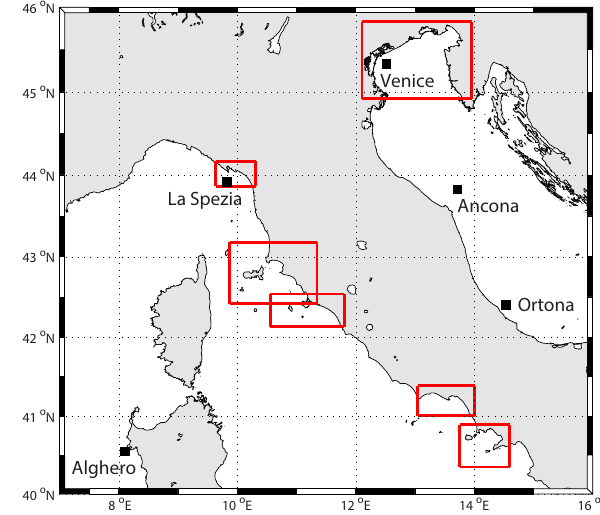
Figure 2. Mc-WAF: implemented regional areas. levels of nesting: the Mediterranean model passes the bound- ary conditions to the regional runs (Fig. 2), each of which, in turn, creates the boundary conditions for all the coastal runs present in the particular regional grid (Fig. 3).